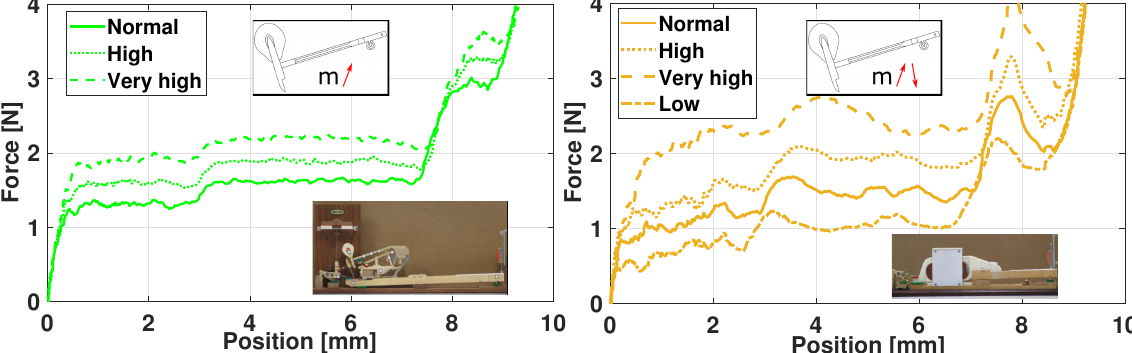
Figure 26. Haptic piano key force validation: variation of the hammer mass, physically on the Renner ® demonstrator ( left ) and virtually on the haptic key prototype ( right